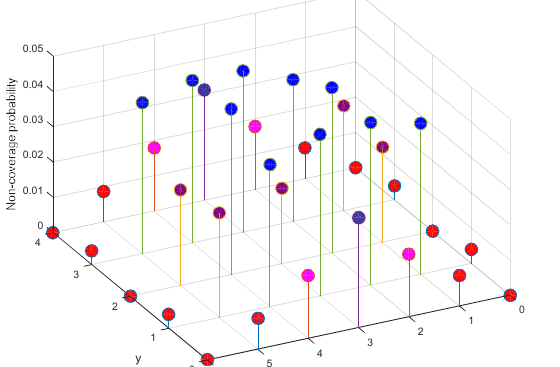
Non-CP of CIs for ER in x , y , m = 6, n = 4 group of binomial experiment configurations ( x from 0 to m , y from 0 to n ) when α = 0.05. Produced with the stem3 function in Matlab. Figure 8. Non-CP for CI ER,5% (0..6, 0..4, 6, 4).